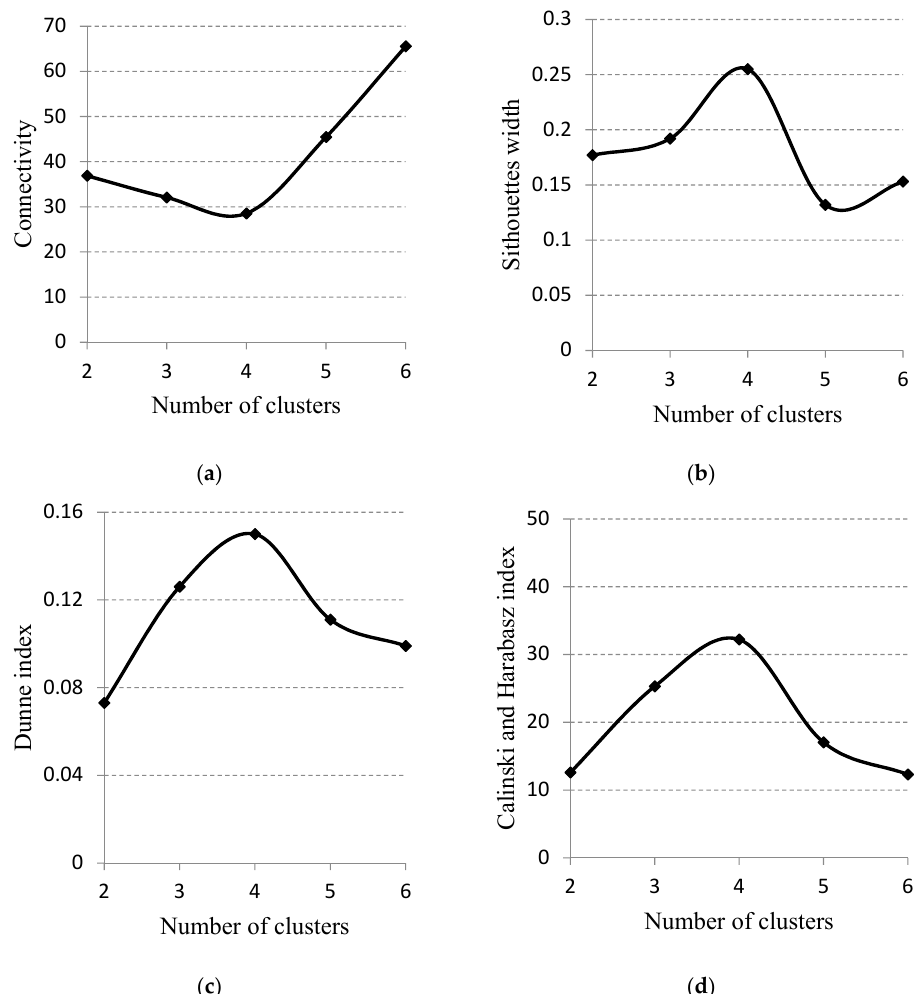
Figure 8. Cluster validation statistics using the plots of ( a ) Connectivity; ( b ) Silhouette width; ( c ) Dunne index and ( d ) Calinski and Harabasz index.